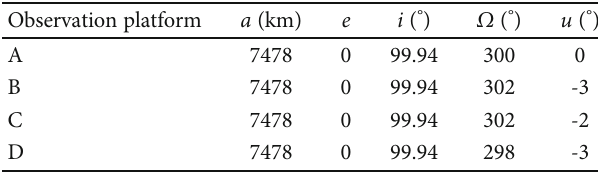
Table 6: The design parameters of proposed formation. Table 7: The initial orbital elements of observation platforms.